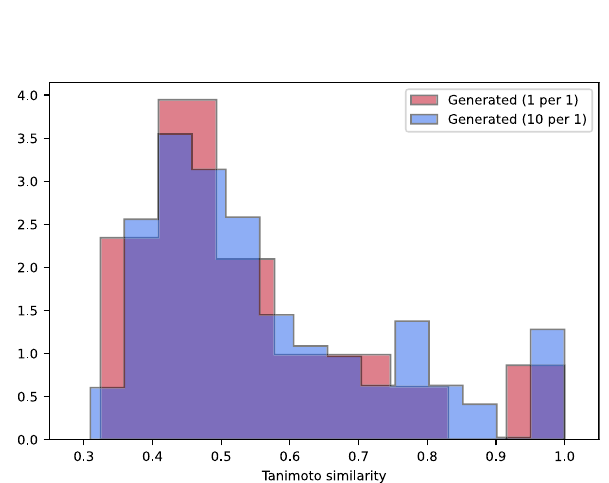
Figure 6. Tanimoto similarity of generated molecules to the nearest neighbor in the training